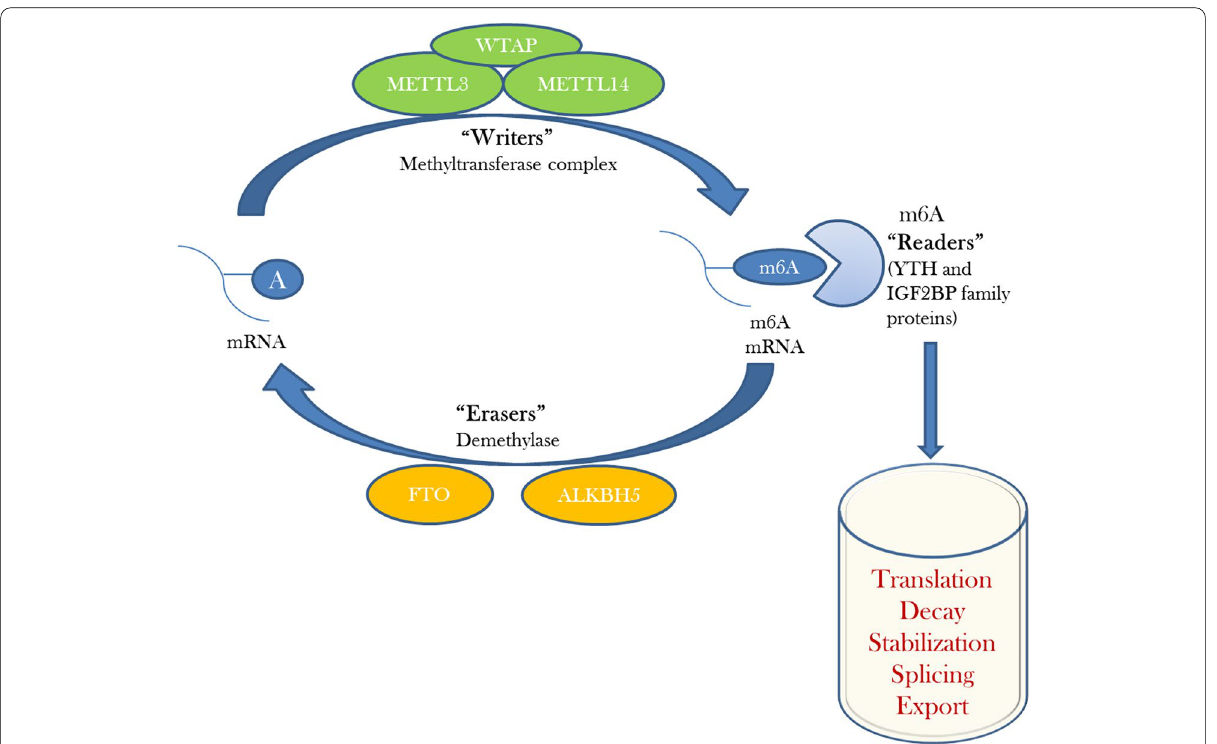
Fig. 4 Regulation of m6A modification and role in RNA